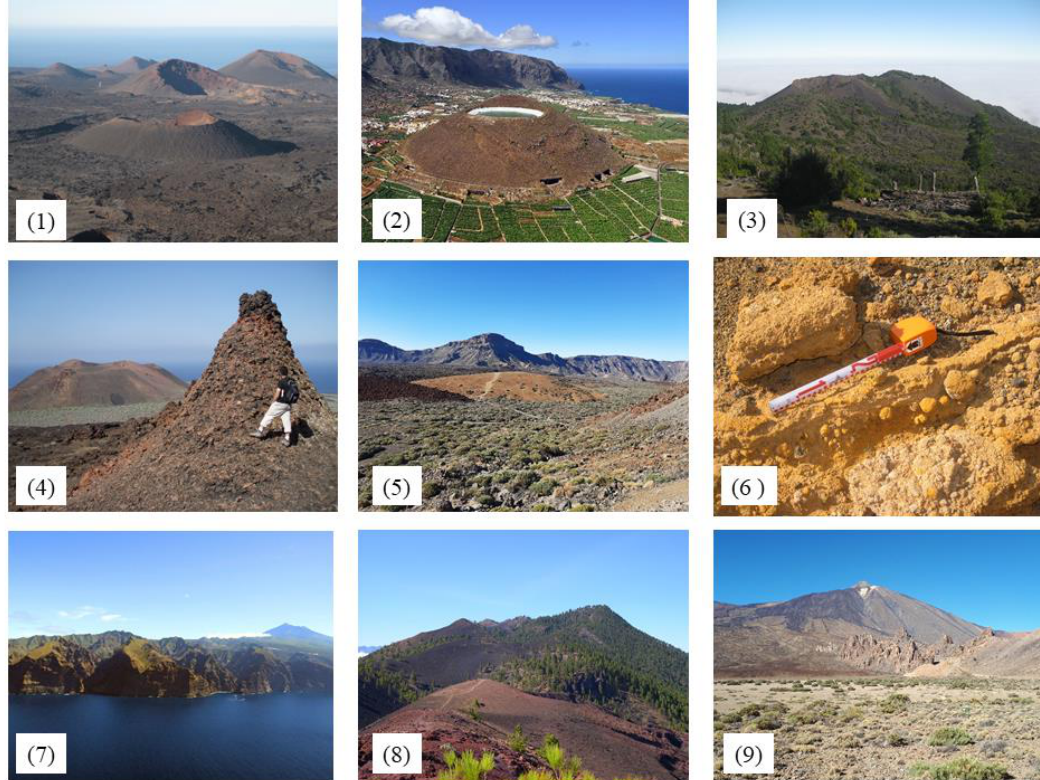
Figure 5. Different volcanic structures of Canary Islands. Cinder cones of Timanfaya National Park in Lanzarote ( 1 ). Cinder cone Montaña Taco in Tenerife ( 2 ). Tanganasoga polyciclic volcanoe in El Hierro Geopark ( 3 ). Hornito in El Hierro ( 4 ). Montaña Majua pumice and phonolitic dome and caldera wall in Teide National Park in Tenerife ( 5 ). Accretionary lapilli in Montaña Cavera tuff cone in Lanzarote and Chinijo Islands Geopark ( 6 ). Teno shield volcano in Tenerife ( 7 ). Cumbre Vieja volcanic rift in La Palma ( 8 ) and Teide stratovolcano in Tenerife ( 9 ). Source: photos 2 and 7 http: //